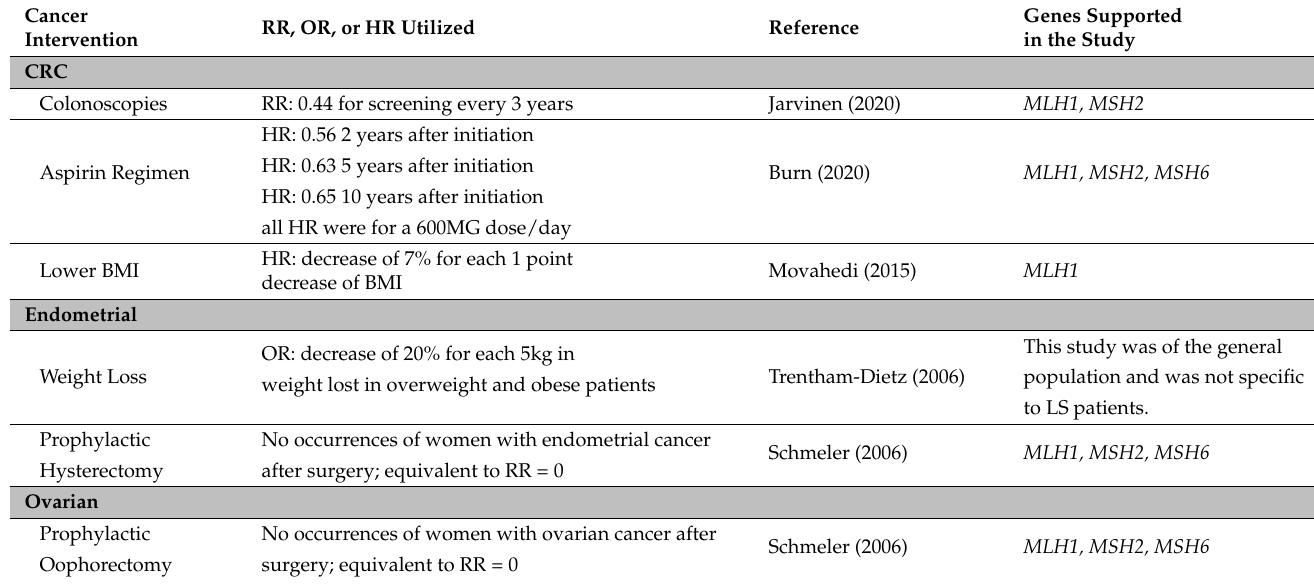
Table 3. References used to estimate the effects of the interventions that were incorporated into MyLynch, by cancer type, with the significant RR, OR, and HR values and the LS genes from those studies. We assumed some RRs, ORs, or HRs for the interventions were applicable to LS genes not included in each study; see the Materials and Methods section for details. Refer to the